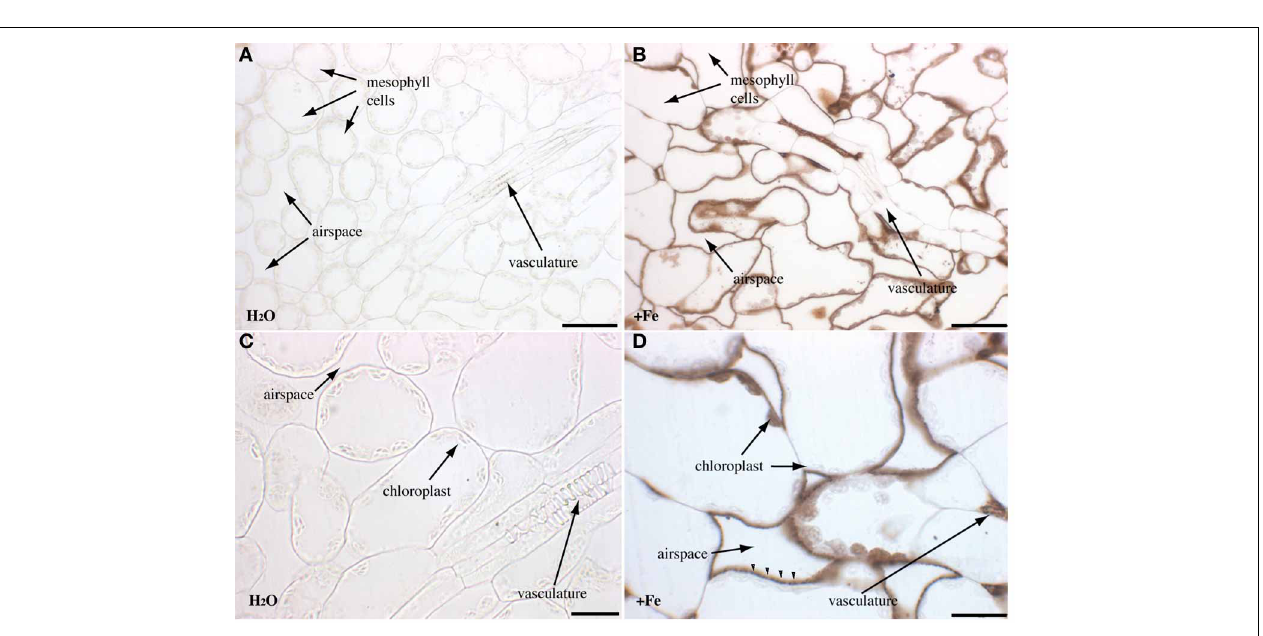
FIGURE 3 | Iron excess in rosette leaves of the Atfer134 triple mutant. Sections of 4-week old Atfer134 plants irrigated with either water (A,C) or Fe-EDDHA 2mM during 48h (B,D) were stained with either Perls/DAB